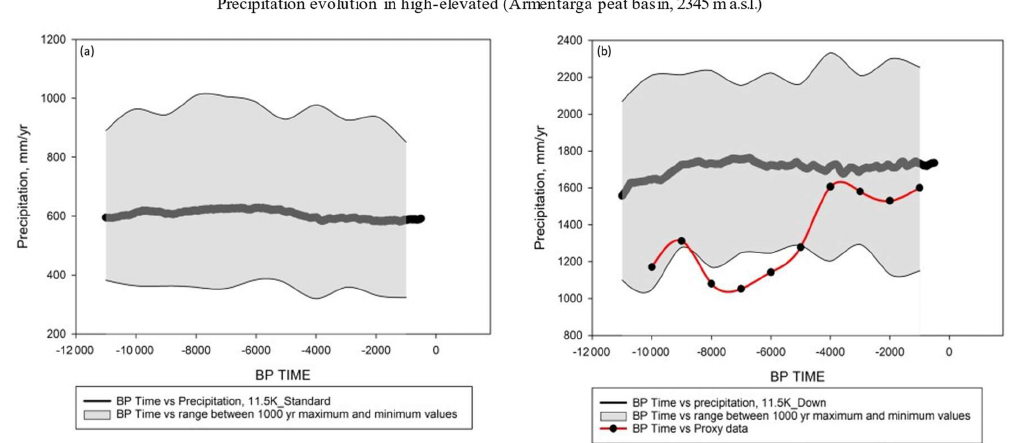
Figure 9. Simulated annual precipitation evolution with the standard version of the model (a) and interactive downscaling plotted with proxy- based reconstructions (Furlanetto et al., 2018), (b) at a high-elevation Armentarga peat site (46 ◦ 2 (cid:48) 26.642 (cid:48)(cid:48) N; 9 ◦ 52 (cid:48) 44.263 (cid:48)(cid:48) E) in the central Alps (2345ma.s.l.). The black line shows the 1000-year running mean of precipitation evolution during the Holocene (in mmyr − 1 ), while the light grey areas represent the range between the maximum and minimum values in the simulations. The red line shows the proxy-based reconstructions at the